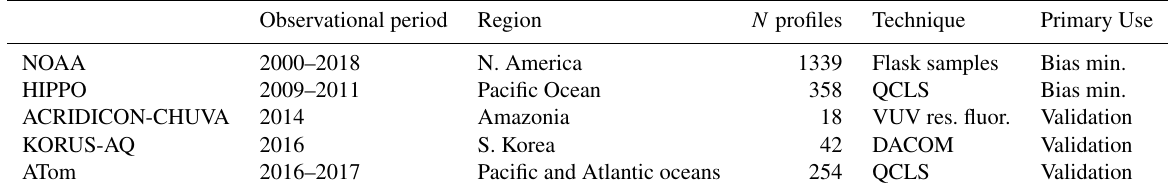
Table 2. Characteristics of CO in situ datasets used for algorithm development (bias minimization) and retrieval validation. See Sect. 3.1. Number of profiles refers only to aircraft-based profiles which were successfully collocated with MOPITT